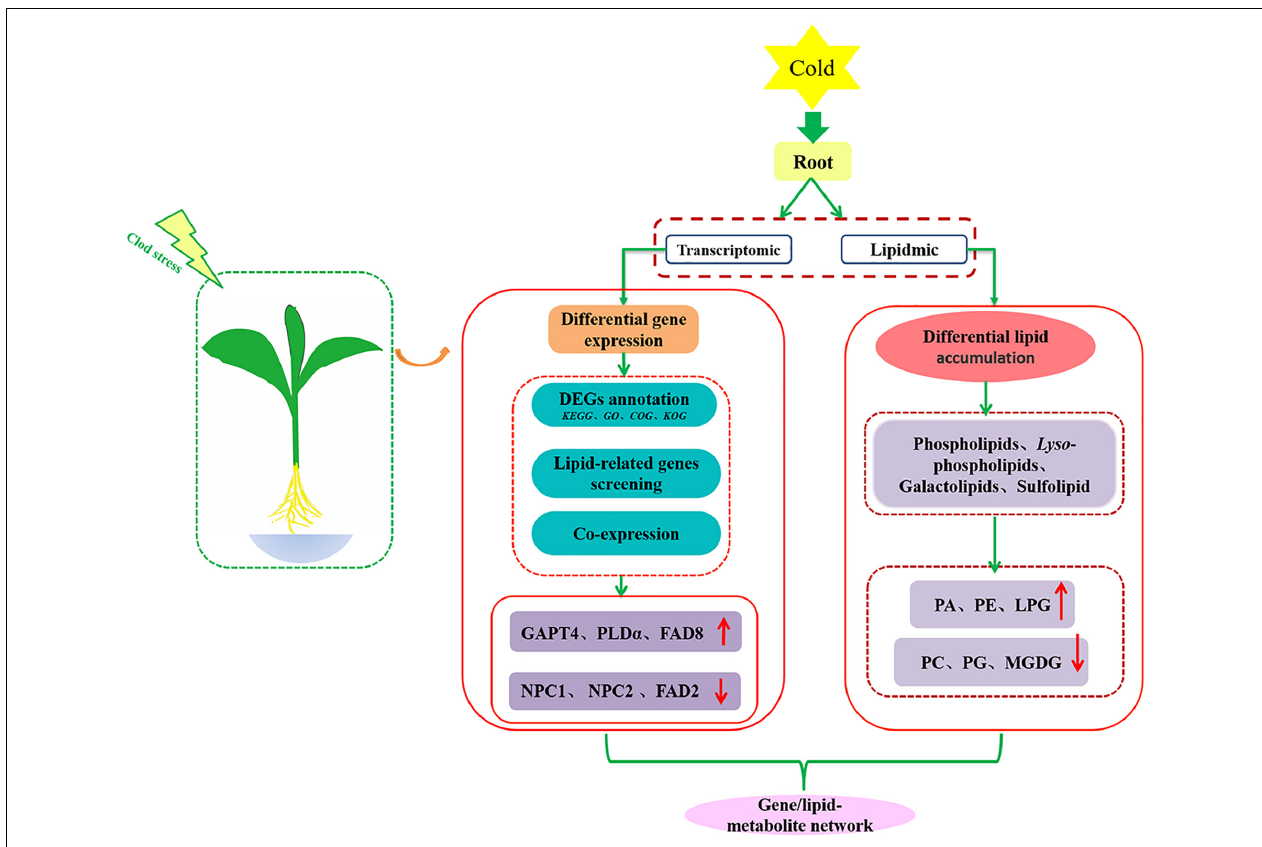
FIGURE 8 | Schematic diagram of transcriptomic and lipidomic analysis